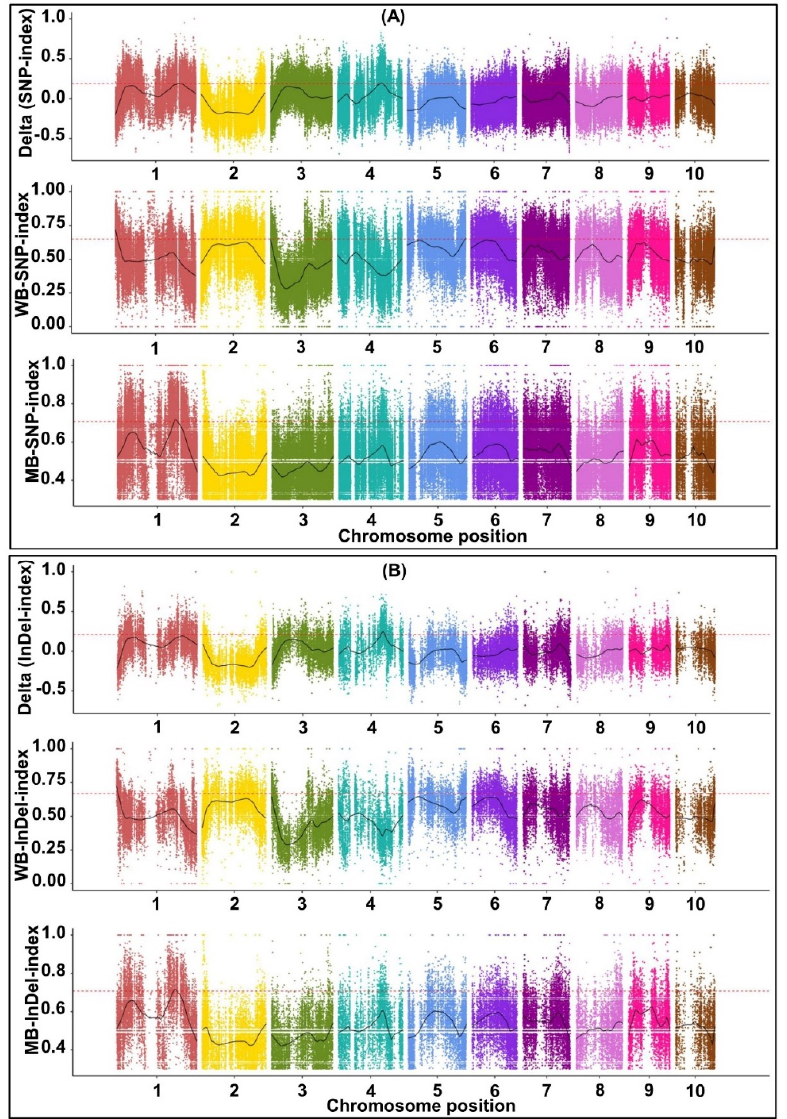
Figure 4. Distribution of SNP index ( A ) and InDel index ( B ) correlation value on chromosomes by BSA analysis of mesocotyl length (MES) under 20 cm sowing environment. The x -axis was the chromosomes, the colored dots represented the calculated SNP ‐ index/InDel ‐ index (or △ SNP ‐ index/ △ InDel ‐ index) value, and the black line was the fitted SNP ‐ index/InDel ‐ index (or △ SNP ‐ index/ △ InDel ‐ index) value. The red line represented the threshold line with a confidence level of 0.99.